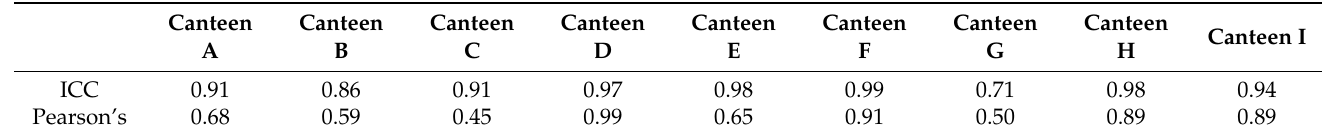
Table 4. Inter-rater agreement and test–retest reliability of Nutrition Environment Scoring for Chinese Style University/Work-site Canteens